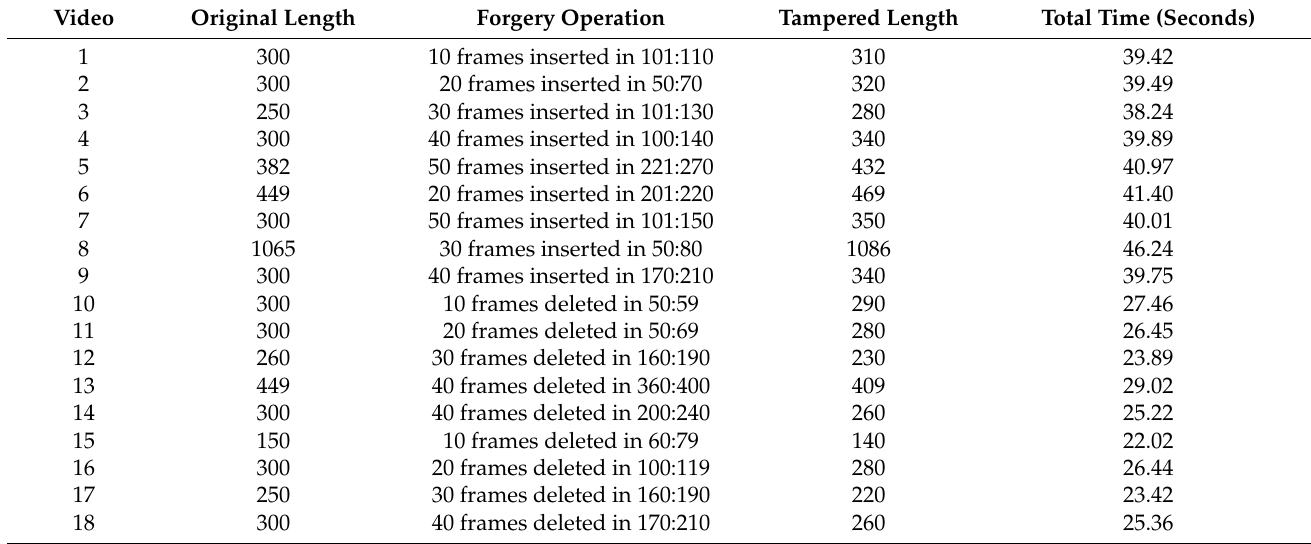
Table 8. Total time needed for Detecting and locating passive